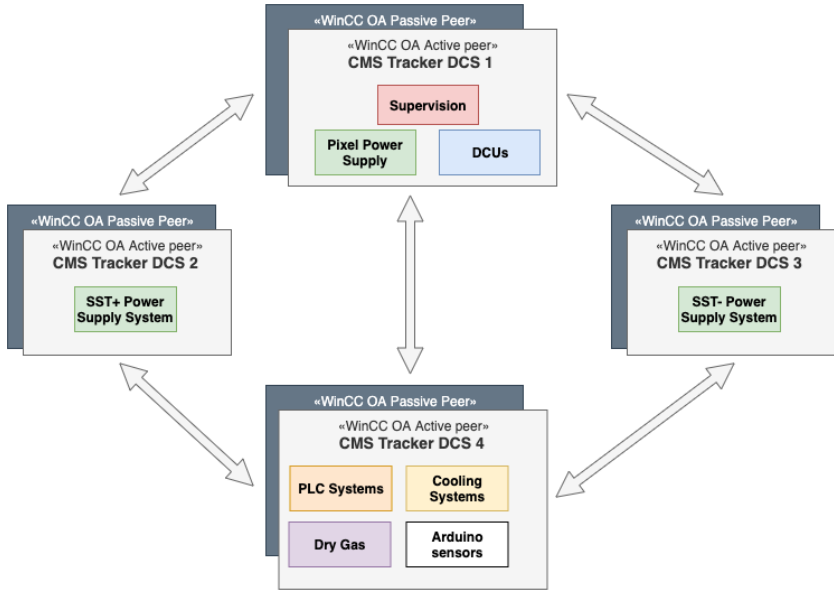
Fig. 2. Distribution of the TCS projects and